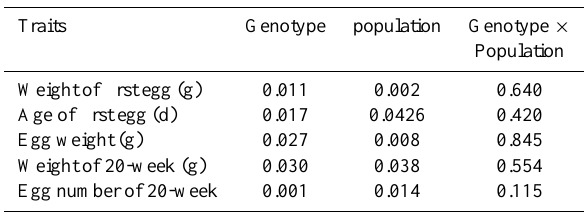
Table 4. Effects ( P value) of polymorphism of VLDLR gene intron 11 on quail laying